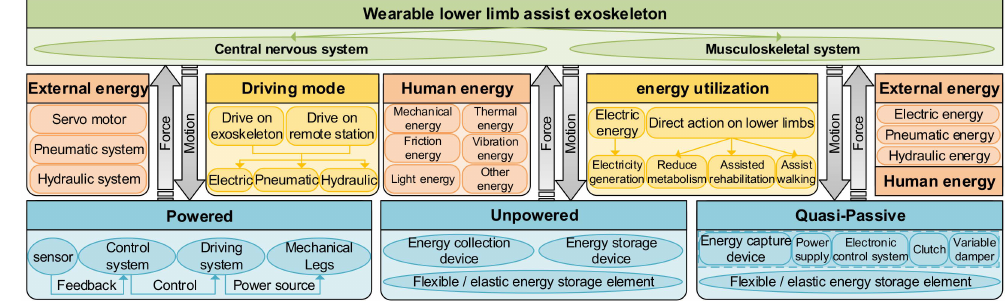
Figure 2. Characteristics of wearable